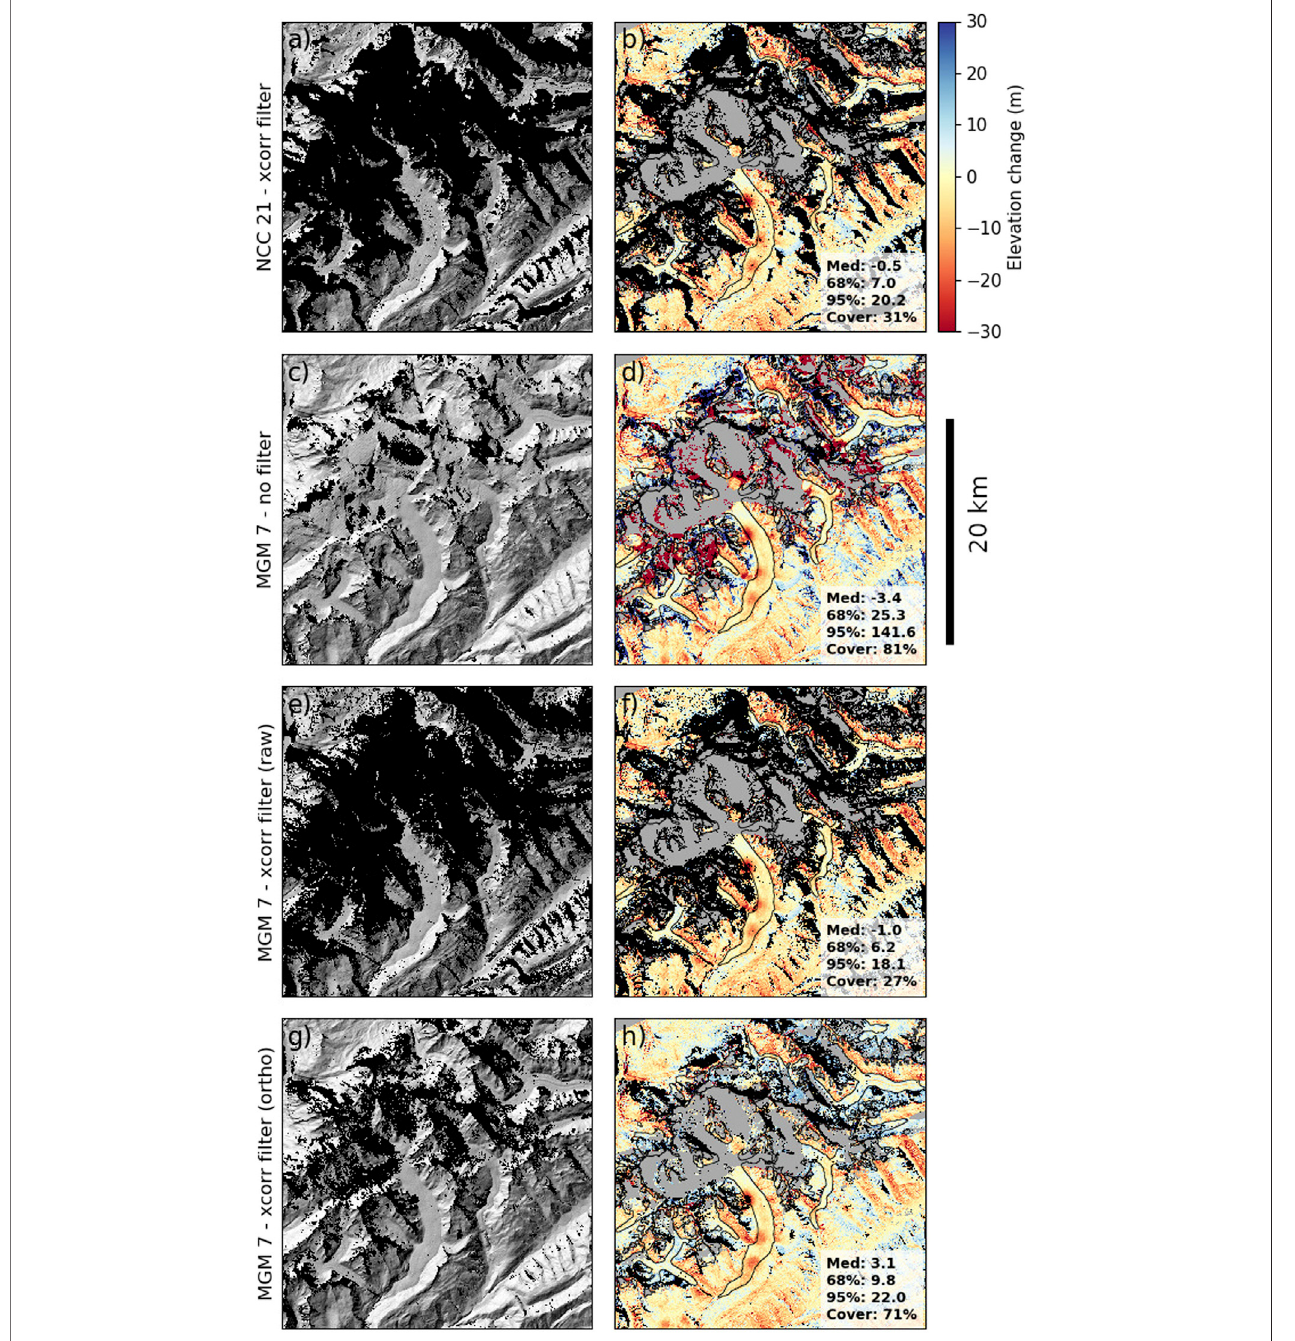
FIGURE 7 | Elevation difference between KH-9 MC and “ Hist 1980 ”” DEMs (right column) and shaded relief of the KH-9 MC DEMs (left column) over parts of the SwissAlpsfordifferentASPstereoprocessingoptions: (A,B) NCCwithkernelsizeof21pixelsand xcorr fi lter, (C,D) MGMwith7-pixelkernelandno fi lter, (E,F) sameas (C,D) with xcorr fi lter, (G,H) sameas (E,F) for orthorecti fi ed inputimages.Black areas represent gaps inKH-9 MC DEMs. In the right column, gray areas represent gaps in the “ Hist 1980 ” DEM. Statistics of the elevation difference distribution [median (Med), 68 and 95 percentile and coverage (Cover)] are reported in each panel.